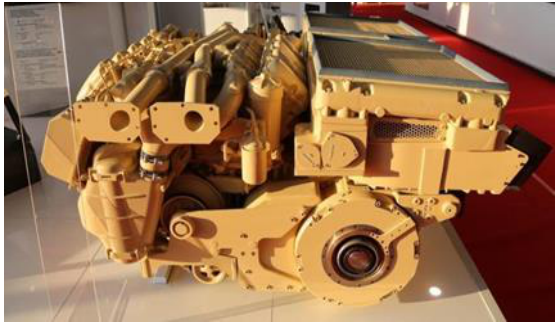
Fig. 6. Renk's PowerPack systems with the designation 350S